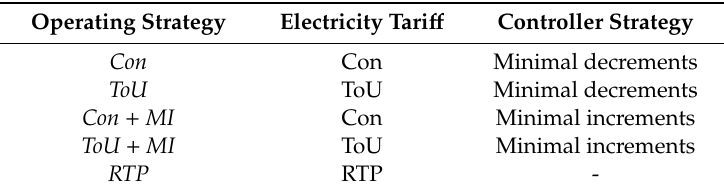
Table 4. Simulated operating strategies that represent the combination of electricity tari ff s and controller